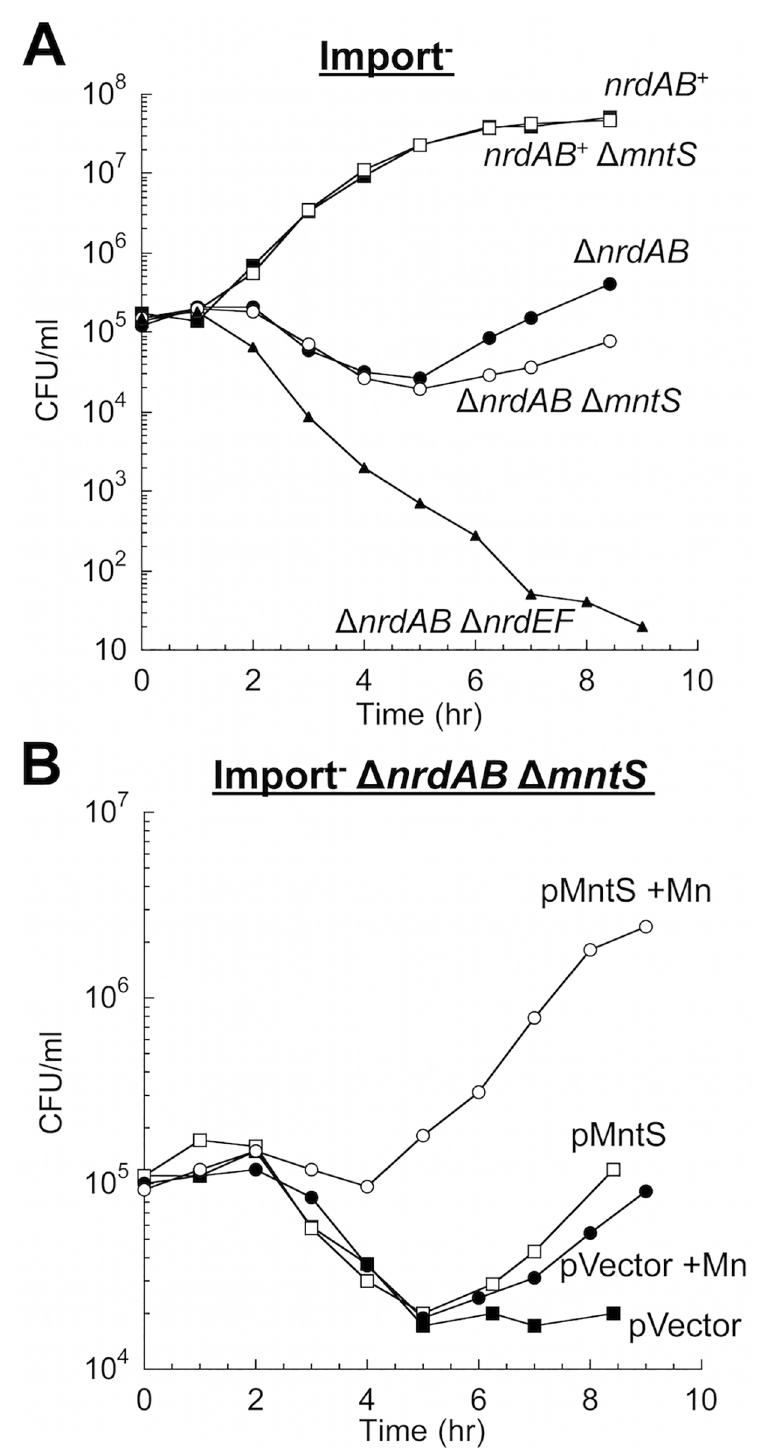
Fig 3. MntS helps activate the manganese-dependent RNR, NrdEF. Cells pre-cultured in anaerobic MOPS glucose/casamino acids medium were diluted into aerobic medium with or without 50 μ M MnCl 2 at time zero; viability was monitored by anaerobic plating. “ Import-minus ” strains contain Δ tonB Δ feoABC Δ zupT null alleles and therefore have reduced iron import. The data are representative of at least three independent experiments. A. Strains were JEM609 (Import - ), JEM1181 (Import - Δ mntS ), JEM1136 (Import